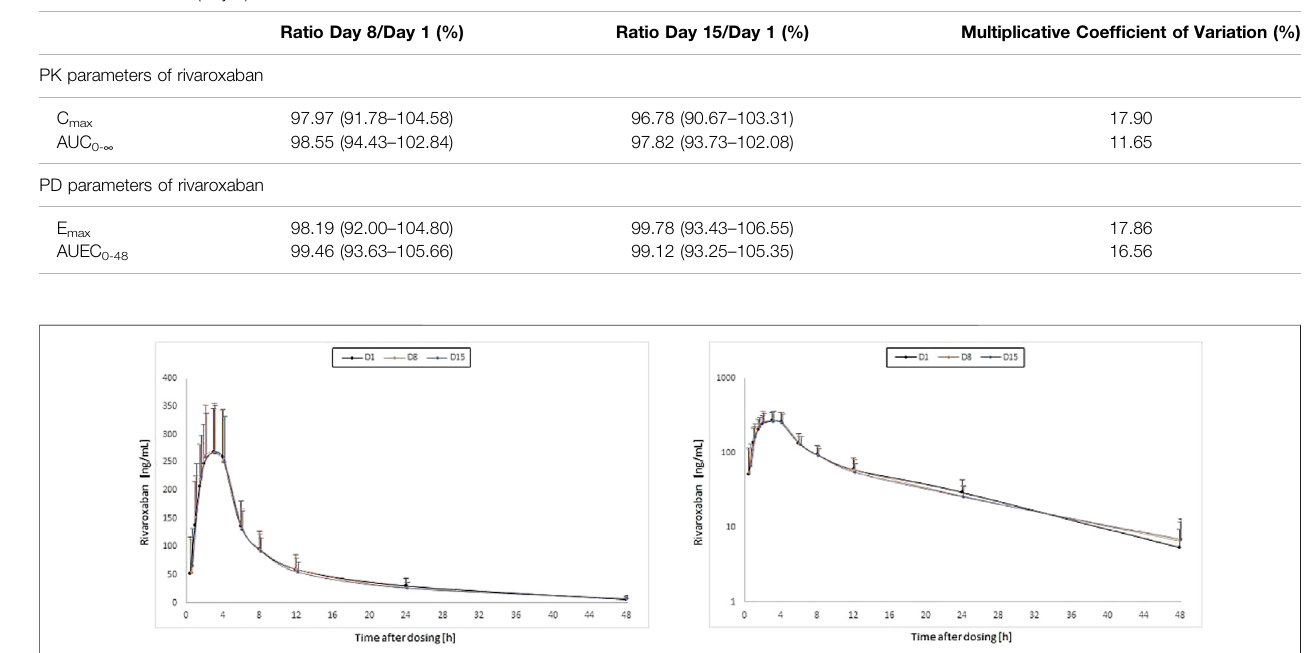
FIGURE 2 | Time courses of the plasma concentrations of rivaroxaban (means, standard deviations; left: linear axis; right: log-linear axis) for single doses of 20 mg rivaroxabanatbaseline(Day1[D1]) andconcomitantlywiththe fi rst(Day8[D8]) andthelastdose(Day15[D15]) ofa1 weektreatment withonce-daily dosingof240 mg EGb 761 ® in 41 healthy